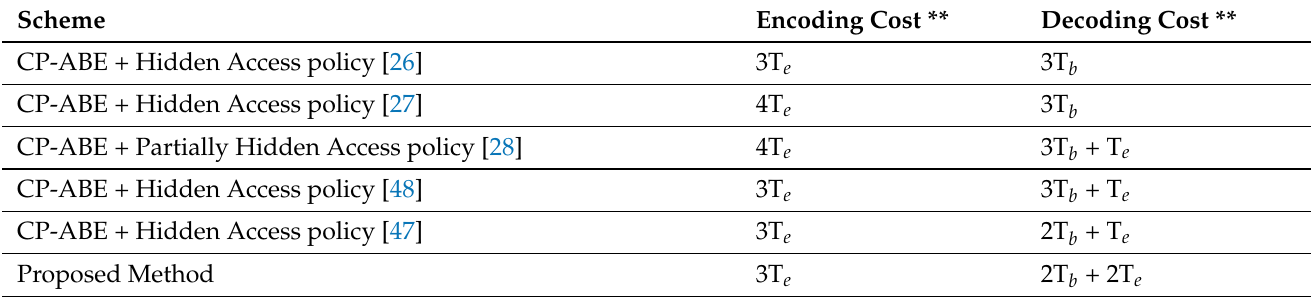
Table 11. Comparison of computations cost analysis with different CP-ABE